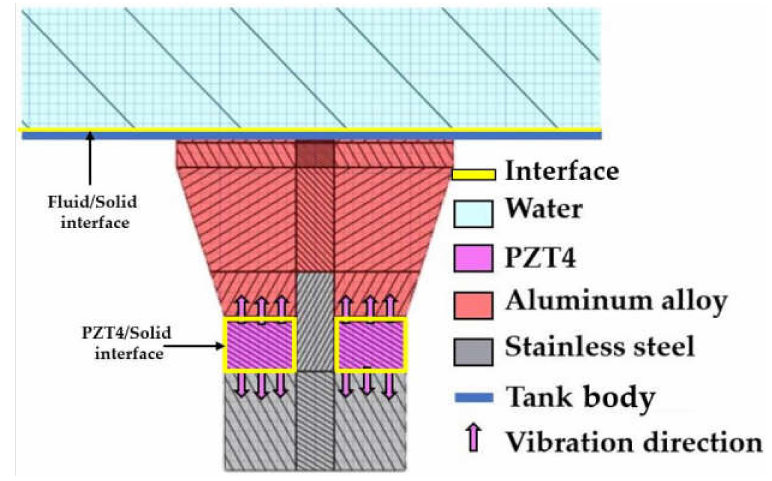
Figure 1. Domains. When alternating current is applied to PZT4 inside the transducer, the PZT4